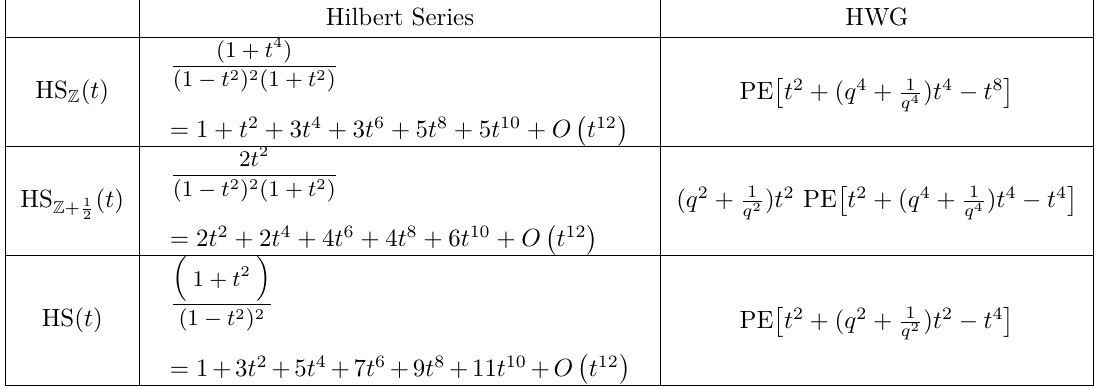
Table 13. Hilbert series for the E 2 magnetic quiver (3.9). The first line of the table provides the Hilbert series when the GNO magnetic lattice is integer HS Z ( t ) , the second line shows the sum over the integers-plus-half lattice HS Z ( t ) and the last line is their sum HS( t ) . In the third column, + 1 2 we show the HWG in terms of fugacities for u (1) (denoted q ). Note that the q -charge is